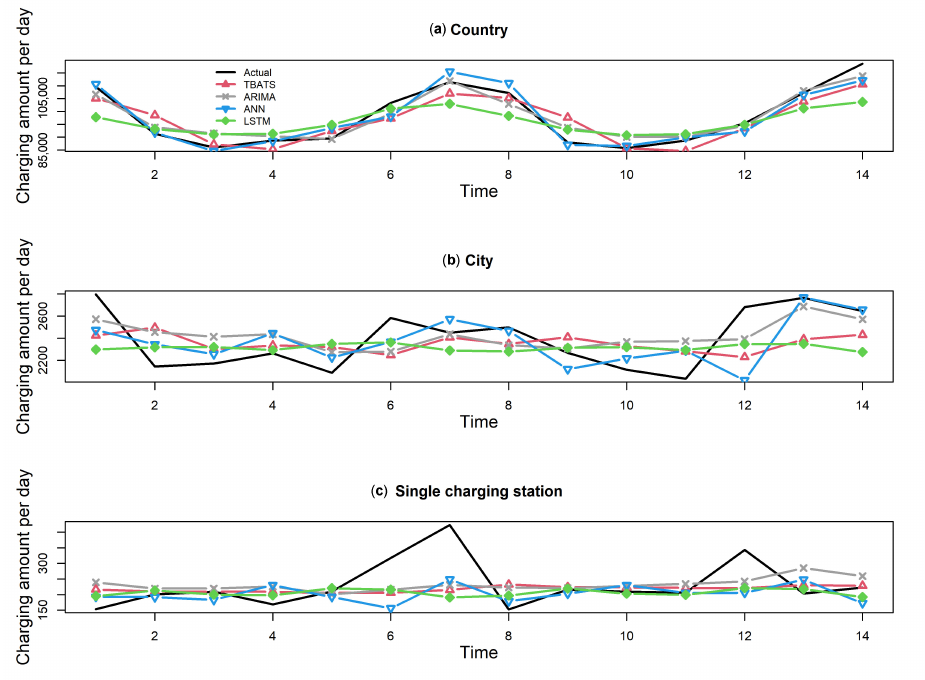
Figure 3. Predicted and actual values for three geographical scales: ( a ) country, ( b ) city, and ( c ) single charging station The y -axis presents the daily energy used (unit: kW/day). The x -axis presents the day in October